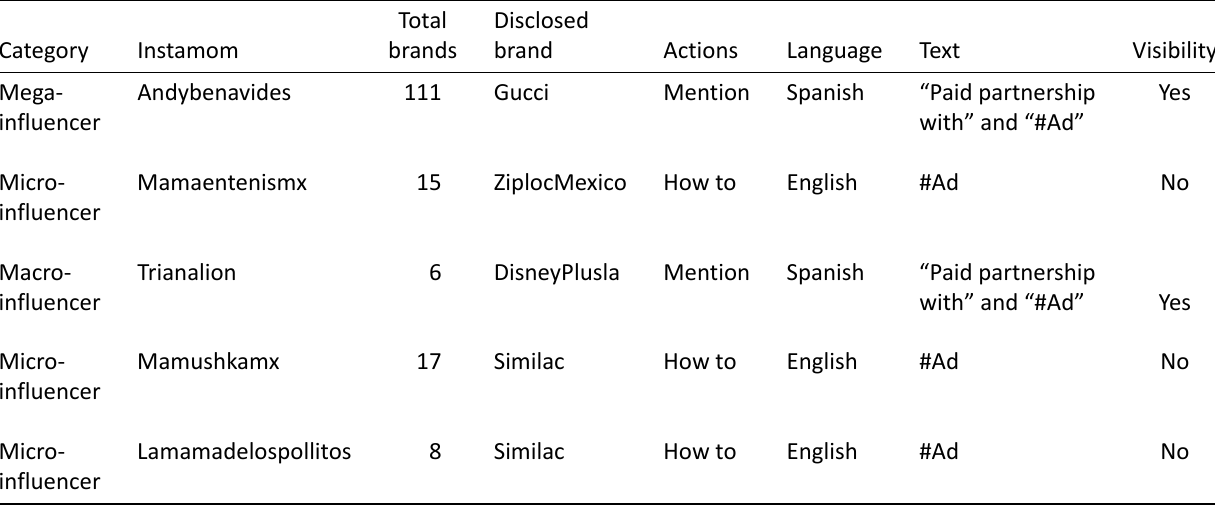
Table 6. Sponsorship disclosure by Instamoms in